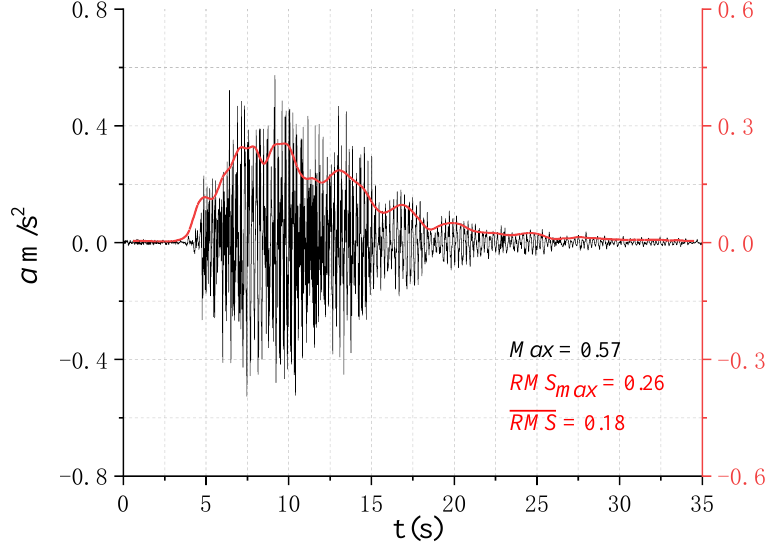
Figure 12. Acceleration time history and RMS.